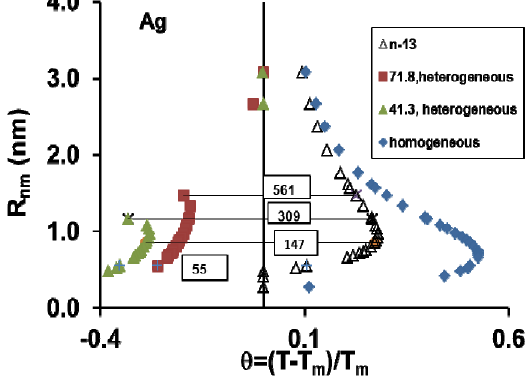
Figure 15. Supercooling temperatures of liquid silver depending on sample volume and controlled by unmelted superclusters having melting temperatures depending on overheating rate applied during 600 s.